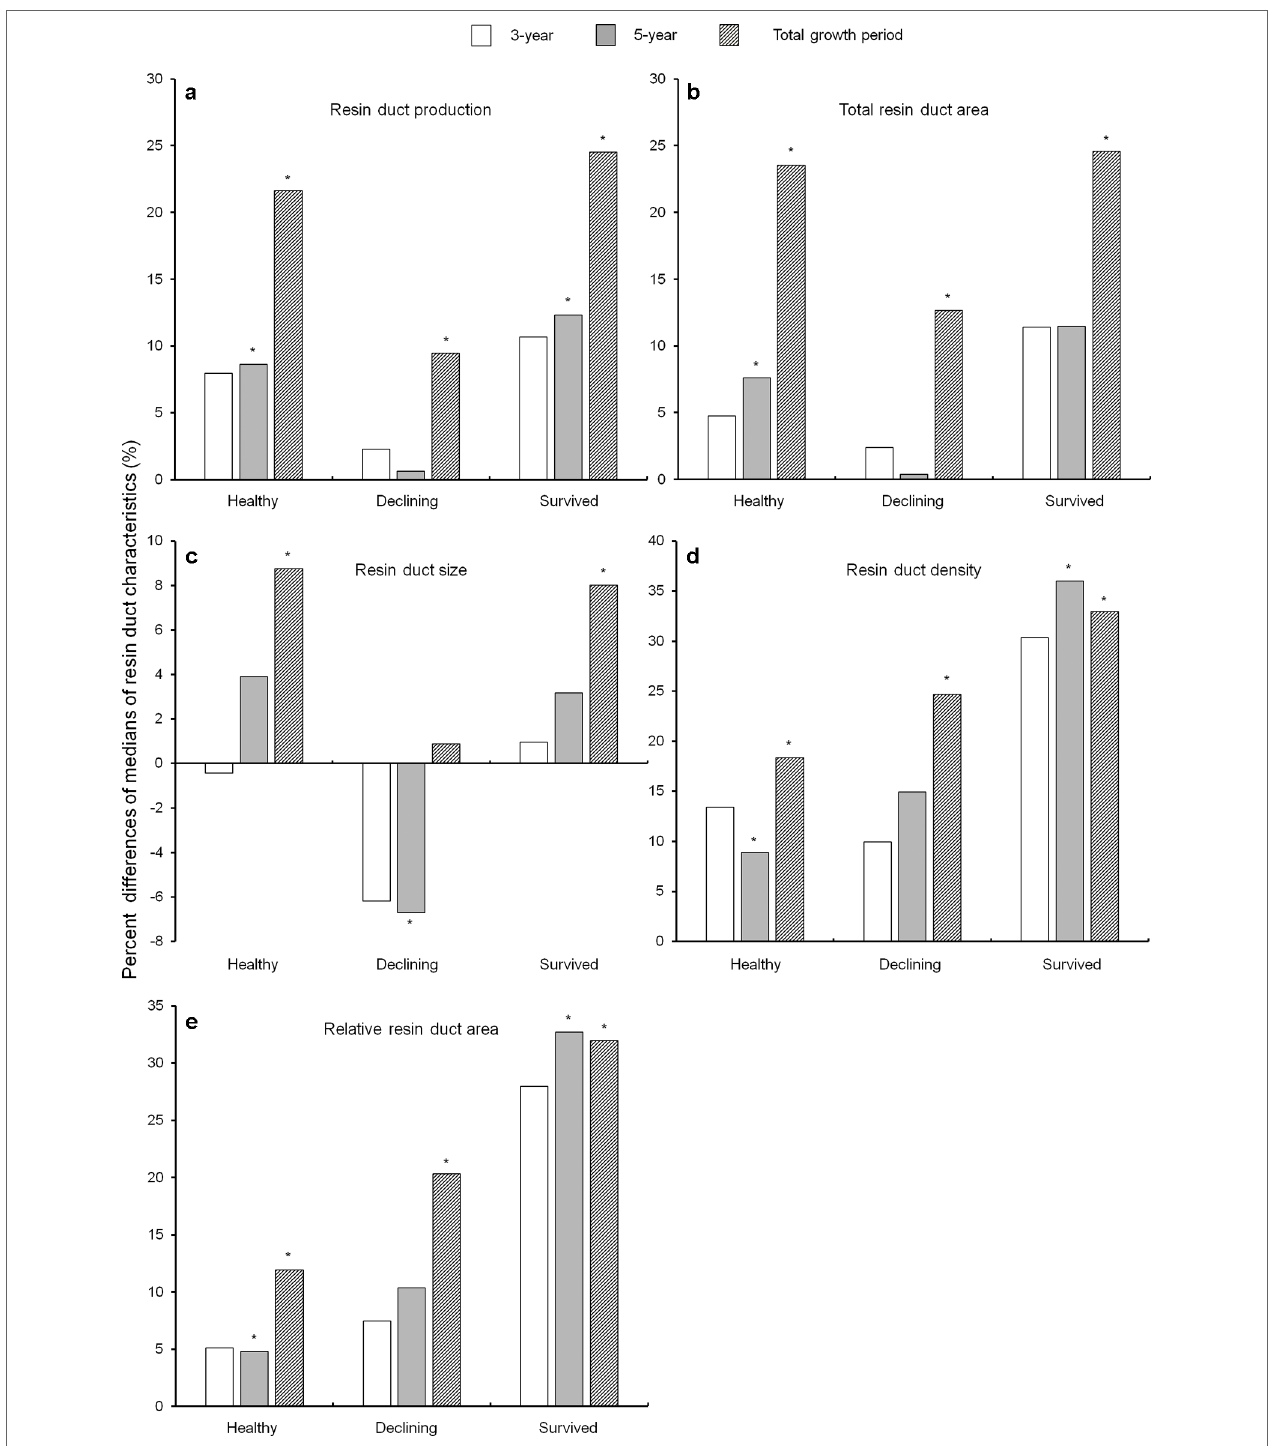
FIgURe 4 | Percent differences of medians of resin duct production (a) , total resin duct area (b) , resin duct size (c) , resin duct density (d) , and relative resin duct area (e) between the 10-year growth period before Dendroctonus ponderosae outbreak and each of the three growth periods after outbreak (3-, 5- and total growth period) in three categories of residual Pinus contorta var. latifolia (healthy, declining, and survived) trees. Significant differences between resin duct characteristics before and after outbreaks (α = 0.05) were indicated by asterisks (*). All resin duct characteristics were log-transformed to stabilize the normality and homogeneity of the variance of model